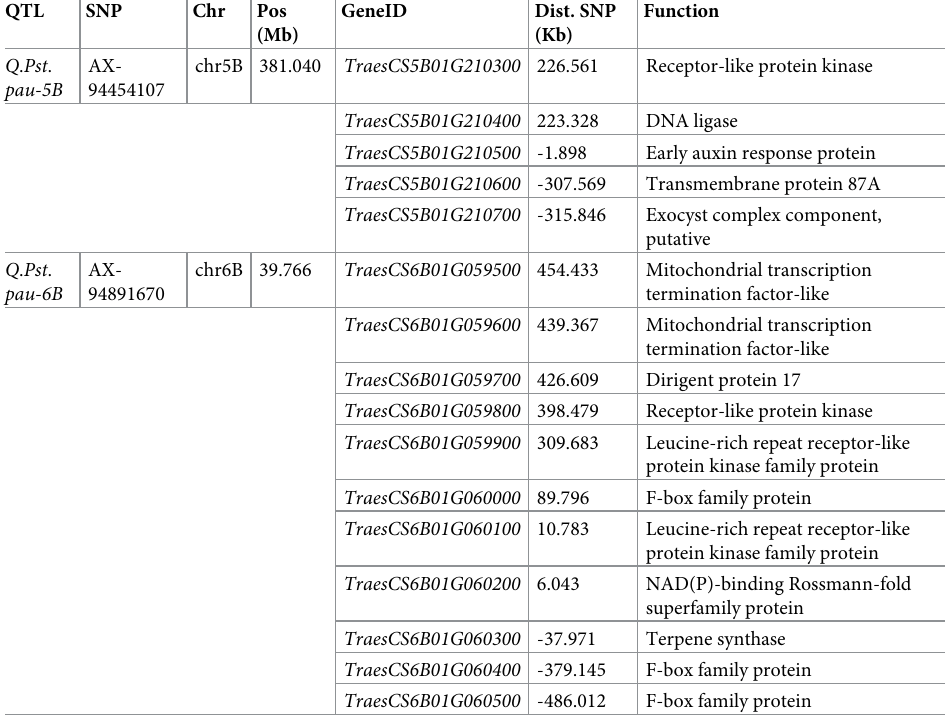
Table 7. Postulation of genes present in the survey sequence of wheat genome